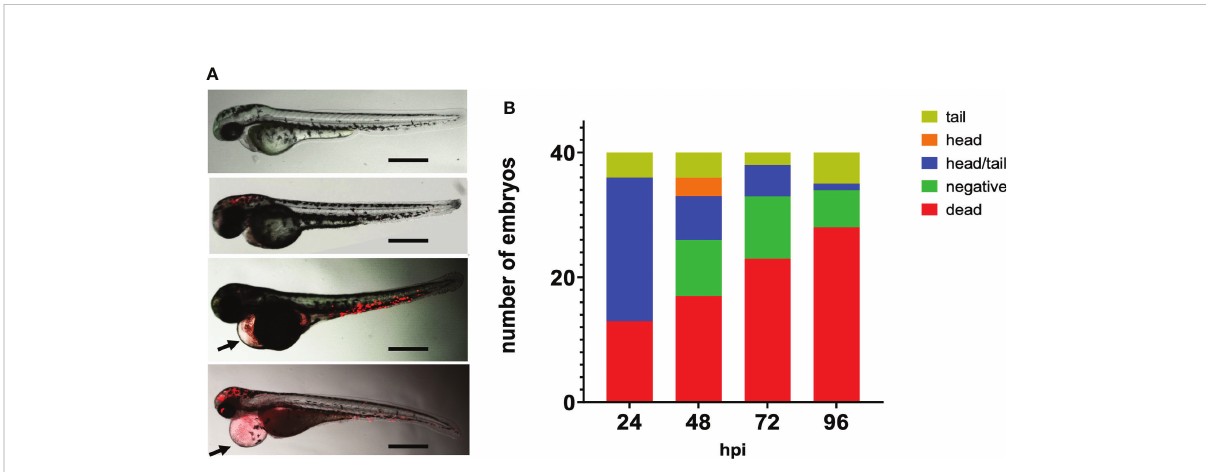
FIGURE 2 Fluorescence microscopy of zebra fi sh embryos at 28 hpf infected with mCherry expressing H44/76_B meningococci (5000 cfu). (A) Zebra fi sh embryos infected with red fl uorescent meningococci. From top to bottom: No meningococci visible, meningococci in the head, meningococci in the tail and meningococci throughout the body. Images taken at 48 hpi; arrow head shows pericardial edema. Bar represents 750 m m. (B) Distribution of meningococci in infected zebra fi sh